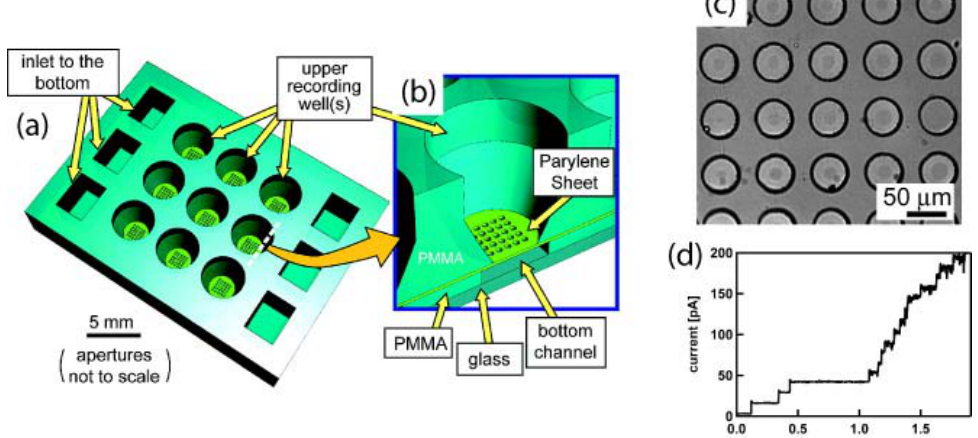
Figure 22. Schematic of the lipid bilayer array chip. Adapted with permission from reference [79]. Copyright 2008 American Chemical